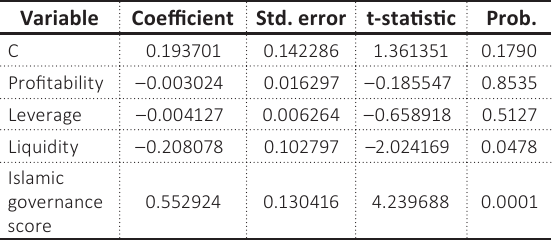
Table 2. Hypotheses testing results